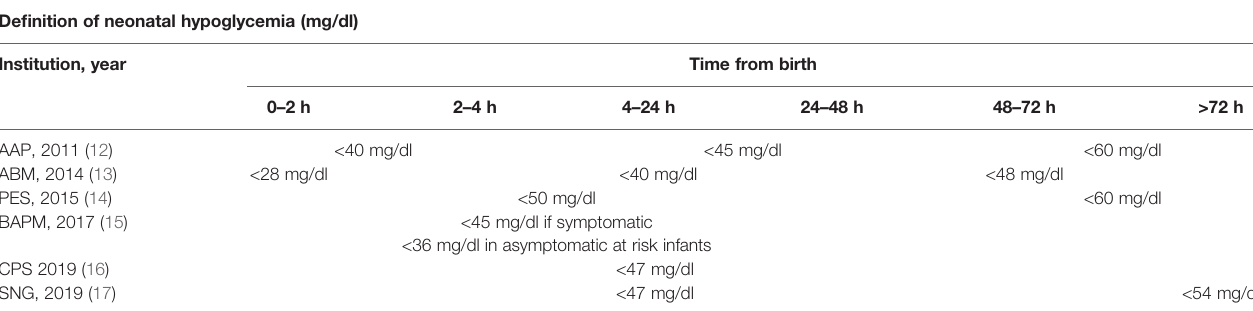
TABLE 1 | De fi nition of neonatal hypoglycemia in the fi rst 72 h from birth, according to the more widespread recommendations. De fi nition of neonatal hypoglycemia